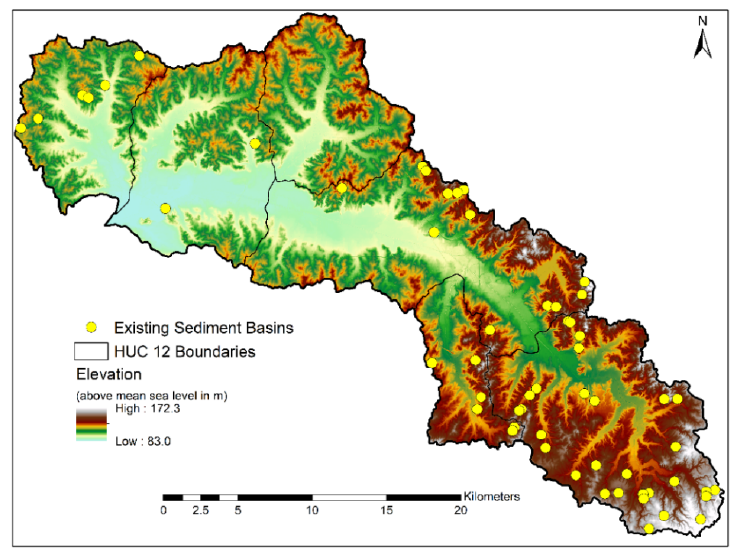
Figure 7. Distribution of existing sediment basins in the study area.